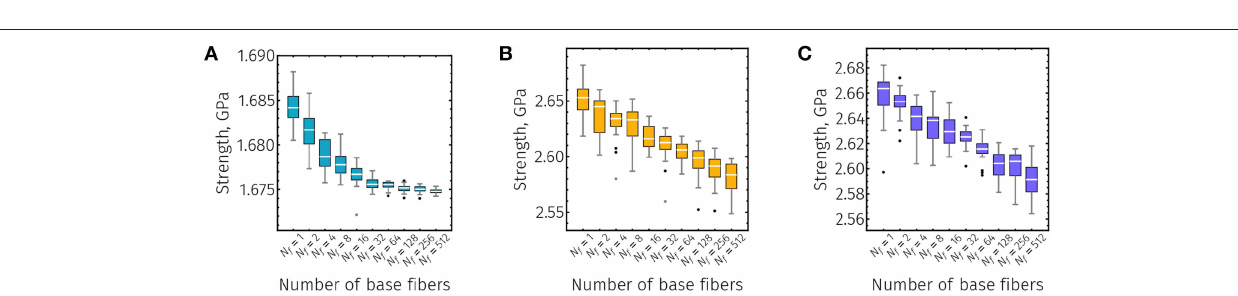
FIGURE 9 | Strength box-whisker plots (20 independent simulations for each structure size) of CNC films with approximate base fiber lengths (A) L = 50nm, (B) L = 150nm, and (C) L = 300nm. Number of fibers ( N f ) refers to number of CNC fibers in series within the simulation volume and scales linearly with simulation size along the direction of loading. White horizontal lines, colored box, gray vertical lines, and black dots indicate the median, interquantile range (IQR) between 3rd and 1st quantiles, range (of all data within ± 1.5 × IQR), and outliers (points outside the range),